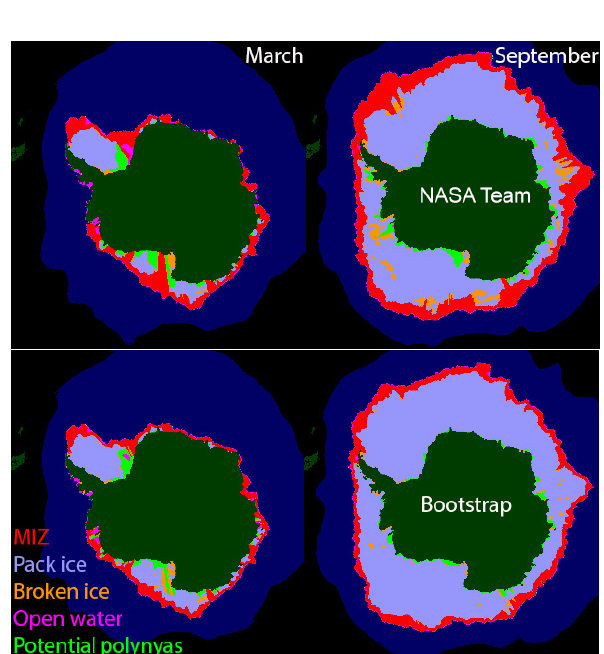
Figure 2. Samples of ice classification on day 70 (March) and day 273 (September) 2013. Results are shown for both the NASA Team (top) and Bootstrap (bottom) sea ice algorithms. The MIZ (red) rep- resents regions of sea ice concentration between 15 and 80% from the outer ice edge; the pack ice is shown in light purple, representing regions of greater than 80% sea ice concentration. Orange regions within the pack ice represent coherent regions of less than 80% sea ice concentration, pink areas open water and green regions of less than 80% sea ice concentration near the Antarctic coastline. Dark blue represents the ocean mask applied to remove spurious ice con- centrations beyond the ice